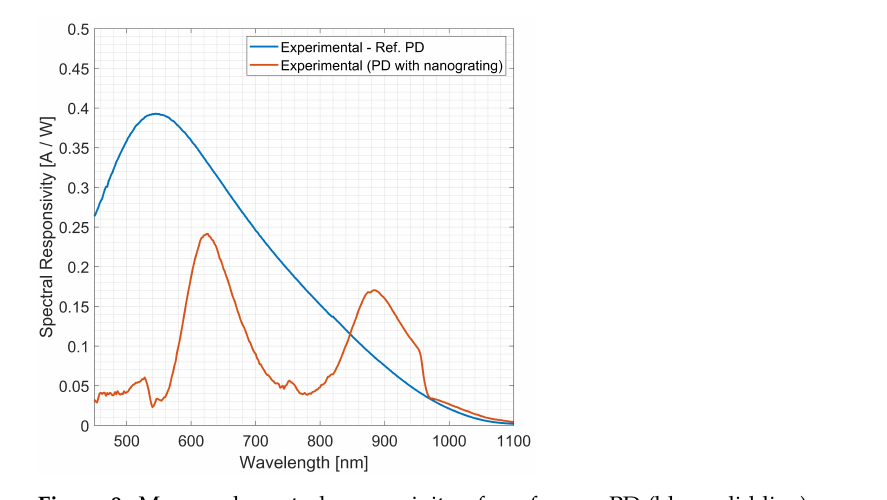
Figure 9. Measured spectral responsivity of a reference PD (blue solid line), measured SR of the integrated PD (orange solid line) as a function of the incident wavelength in the range (450–1100) nm.